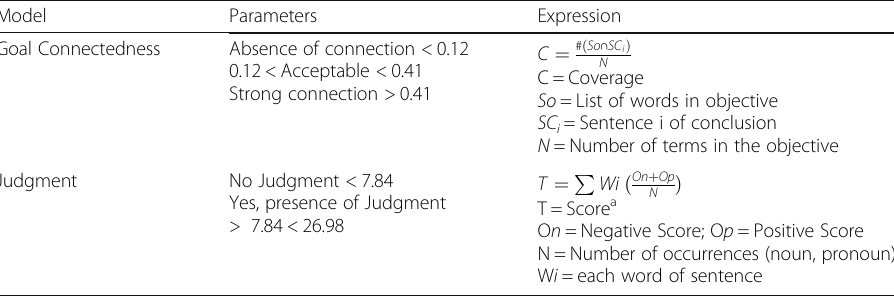
Table 3 Formulas and Parameters